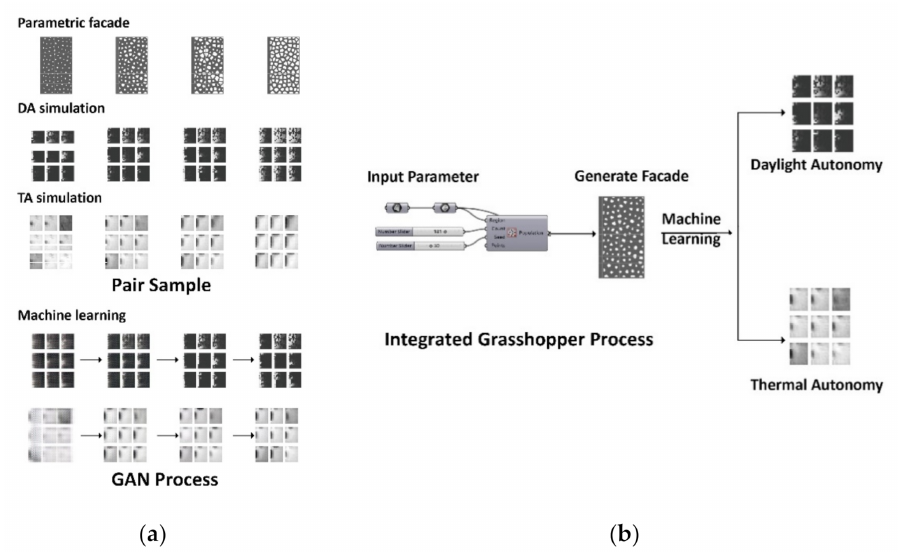
Figure 13. GAN and Grasshopper process: ( a ) dataset preparation for training the machine learning model; ( b ) output of machine learning